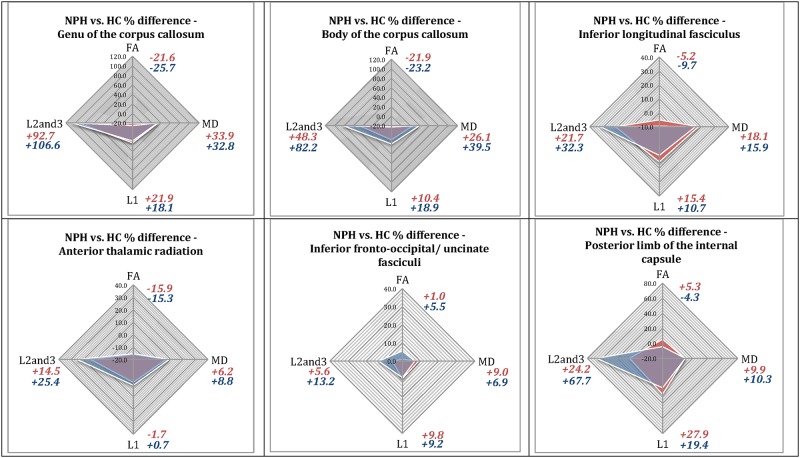
DTI profiles in pre-operative and post-operative NPH patients vs. healthy controls (in percentage difference (%)).Illustration of DTI profiles—Four measures comprising the full panel for DTI interpretation, (FA, MD, L1 and L2and3), are visually represented as radar graphs. Differences in measures may be viewed concurrently; each axis is scalar and dimensionally comparable. The morphology of the graph, i.e. the shape of the radar web, is dependent upon i) the degree of differences between the two groups compared (the larger the differences, the bigger the area of the radar web) and ii) the DTI measure predominantly affected (the radar web points towards the DTI measure with the highest percentage difference between the groups).